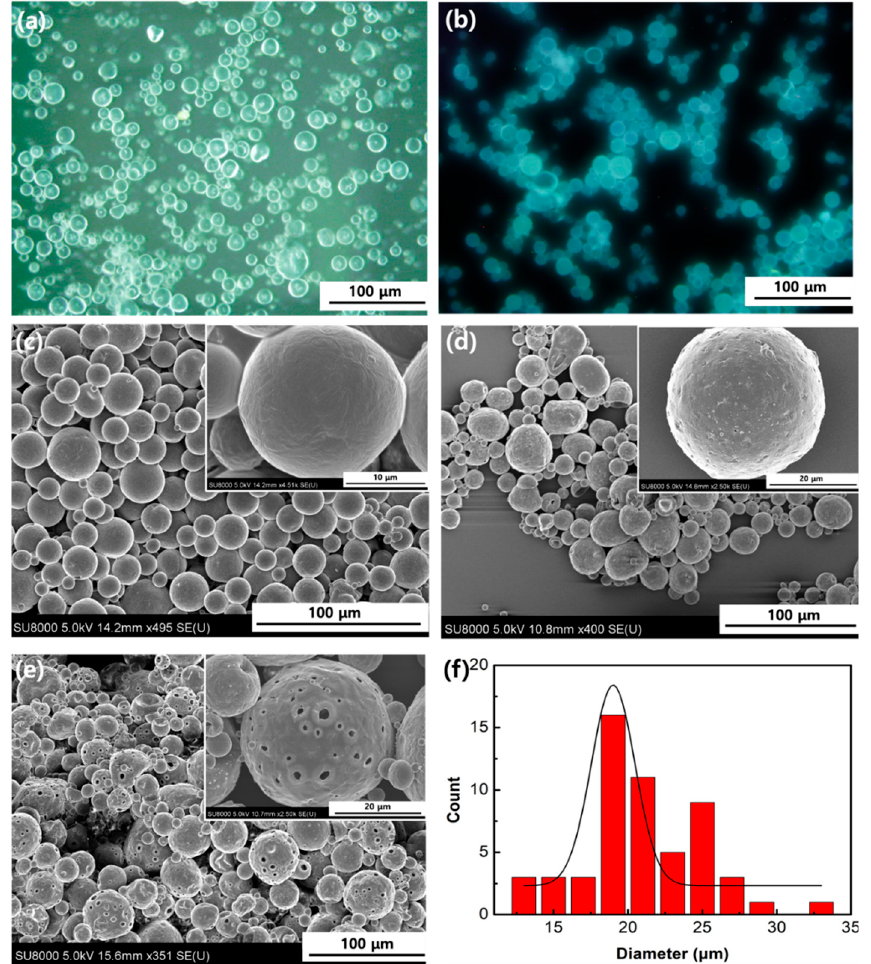
Figure 2. ( a ) Optical microscope image of 2-((pyrene-1-ylmethylene)amino)ethanol/magnetic nanoparticles (PE/MNPs) microcapsules; fluorescence image of ( b ) a cluster of PE/MNPs microcapsules; scanning electron microscopy (SEM) images of ( c ) hollow microcapsules and a single hollow microcapsule (inset); ( d ) a cluster of PE/MNPs microcapsules and a single PE/MNPs microcapsule (inset); ( e ) porous microcapsules under high centrifuging speed. ( f ) particle size distribution histogram of PE/MNPs microcapsules in ( c ).